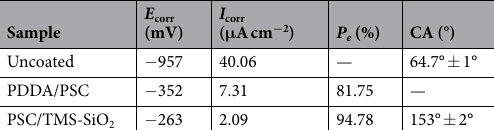
Table 2. The corrosion parameters obtained from polarization curves of uncoated and coated